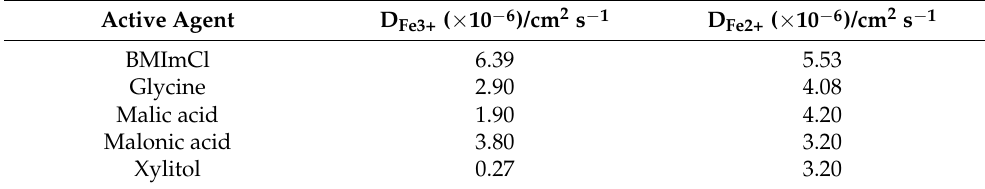
Table 4. The diffusion coefficients of Fe 3+ (D Fe3+ ) and Fe 2+ (D Fe2+ ) in different solutions. Active